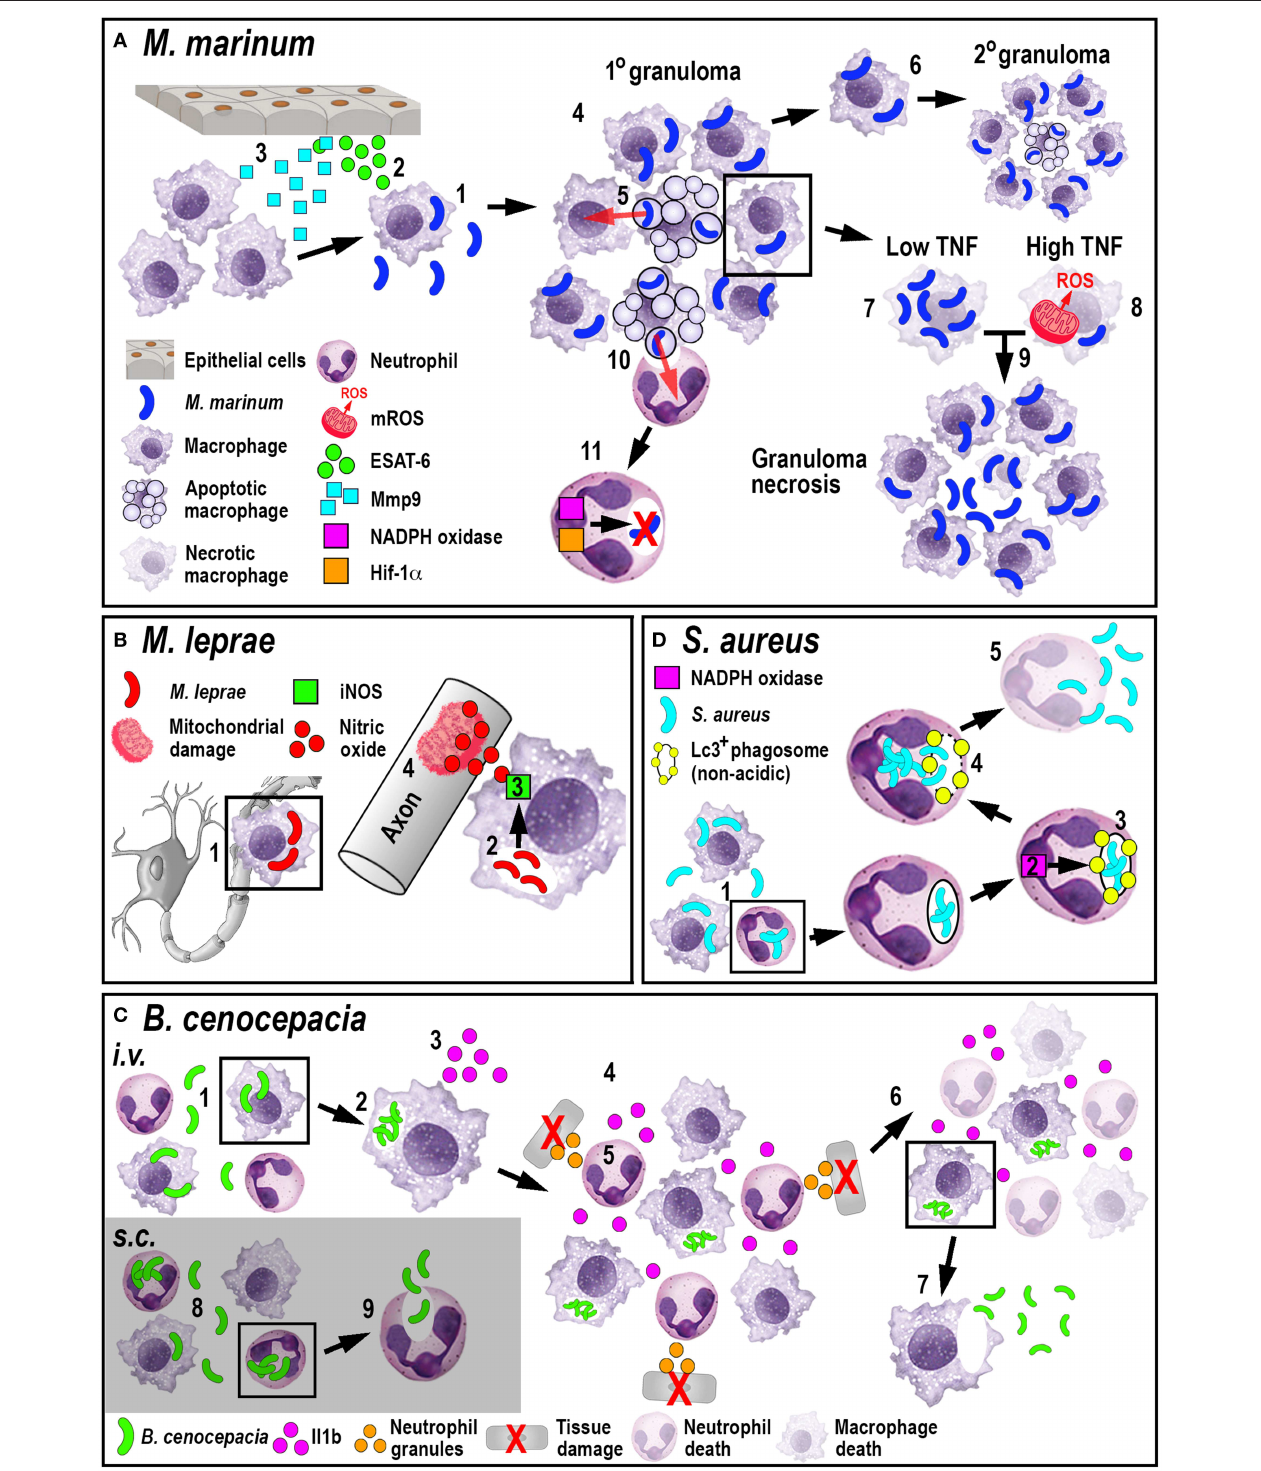
FIGURE 2 | Schematic illustration of the phagocyte responses to the bacterial pathogens M. marinum (A) , M. leprae (B) , B. cenocepacia (C), and S. aureus (D) . (A) Macrophages phagocytose M. marinum (1) and release ESAT-6 (2). ESAT-6-driven Mmp9 production by epithelial cells leads to macrophage recruitment (3) and granuloma formation (4). Newly-arriving macrophages become infected by engulfing dying infected macrophages (5). Infected macrophages can establish secondary